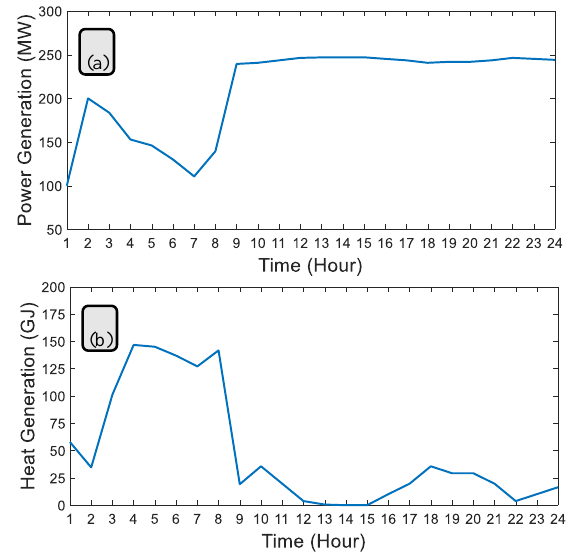
Figure 9. Optimized operation of CHP ( a ) power generation and ( b ) heat generation.